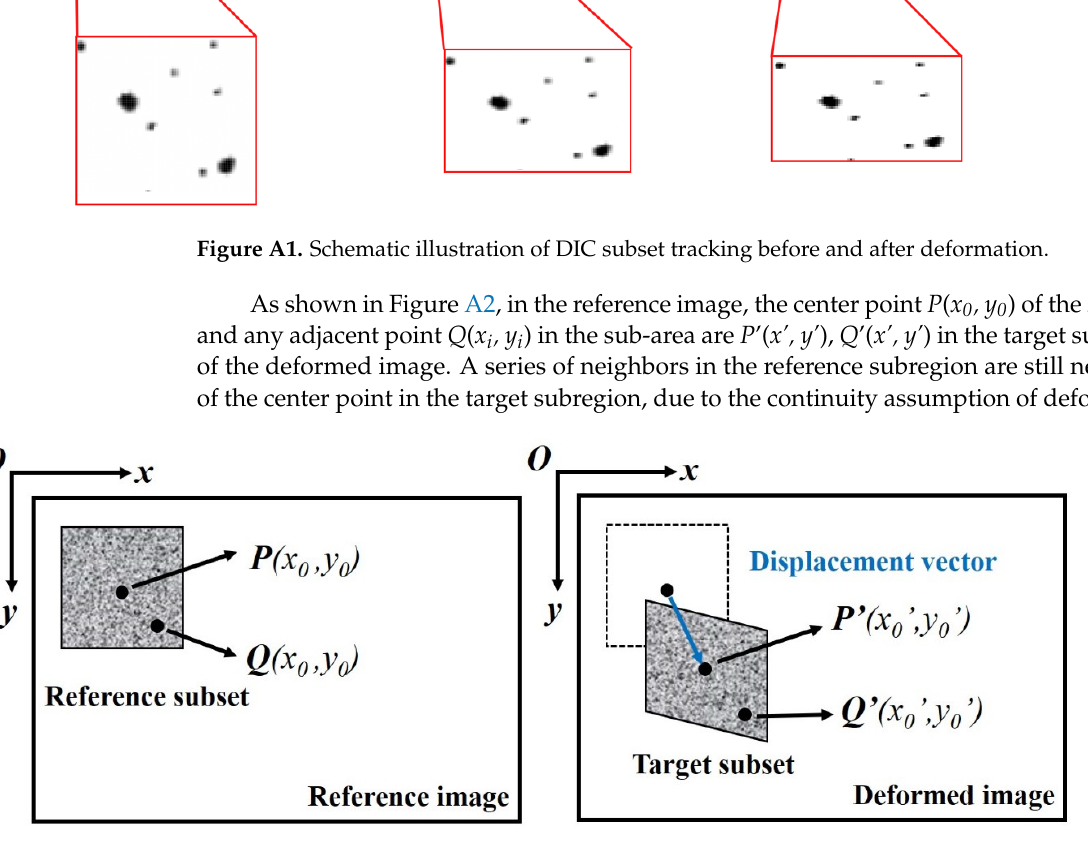
Figure A2. Schematic illustration of a reference square subset before deformation and a target (or deformed) subset after deformation.